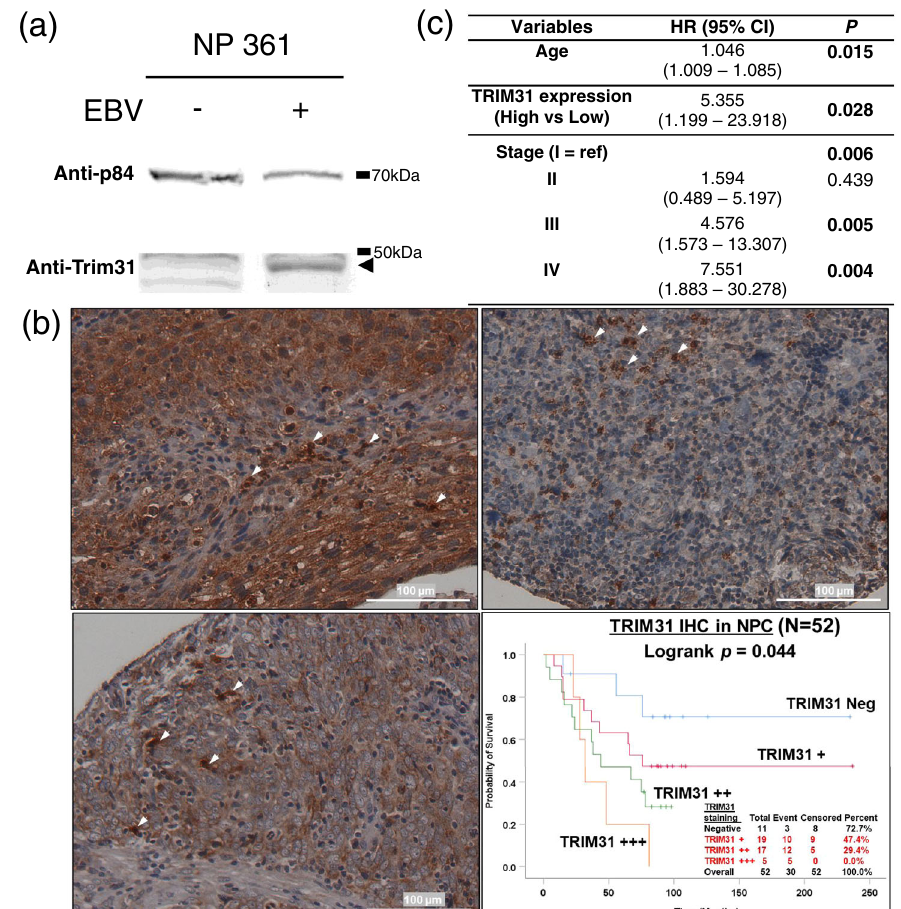
Fig. 4 Correlation of TRIM31 expression and survival. a TRIM31 expression in EBV-infected normal immortalized nasopharyngeal epithelial cell line, NP361. Supplementary Fig. 7 showed the uncropped blots. b TRIM31 immunohistochemical staining clinically associated with poor survival in NPC. Representative images of NPC cells showing (upper right panel) high ( +++ ) positive staining, (lower left panel) low ( + ) positive staining, and (upper left panel) negative TRIM31 expression in NPC tissue microarray after immunohistochemical staining. White arrowheads indicate the TRIM31-positive in fl ammatory cells. (Scale bar, 100 µ m) For a subset of NPC with TRIM31-positive in fl ammatory cells, Kaplan – Meier survival analysis (lower right panel) indicates an association between higher TRIM31 expression in NPC and poorer survival compared to negative TRIM31 expression in NPC. c Multivariate COX regression analysis of age, TRIM31 expression, and stage with survival in NPC patients ( n =